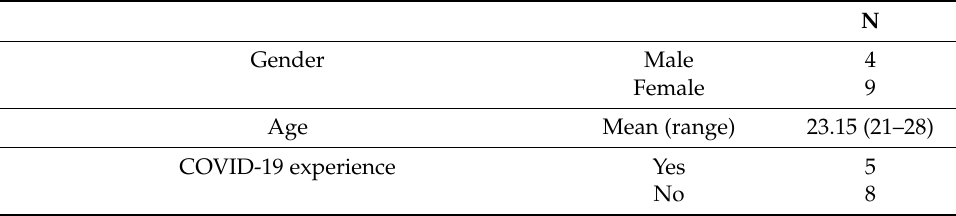
Table 2. Sociodemographic